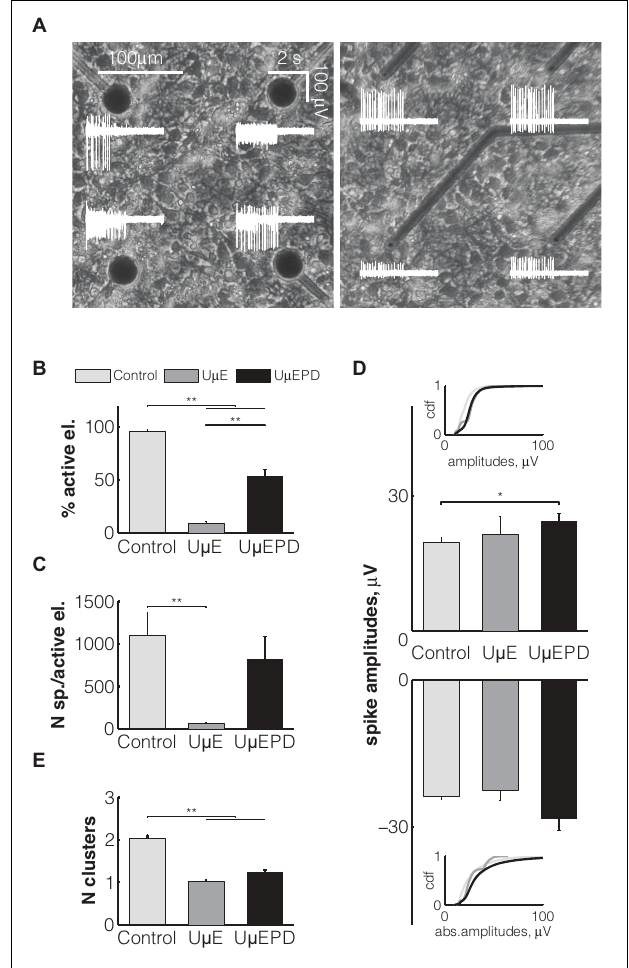
FIGURE 3 | Optical and electron microscopy. (A) Optical micrographs (left) and SEM of FIB cross-sections of bare (above) and PEDOT:PSS-coated (below) gold ultramicroelectrodes. Electrodeposition of PEDOT:PSS produced a thin conformal layer. (B) Internal defects in an electrode were revealed by FIB cross-sections. Gold electroplating for this electrode used a current of − 1.5 nA, in comparison to − 0.4 nA for the electrodes in A. The scale bars in A apply to other optical and SEM images, respectively.